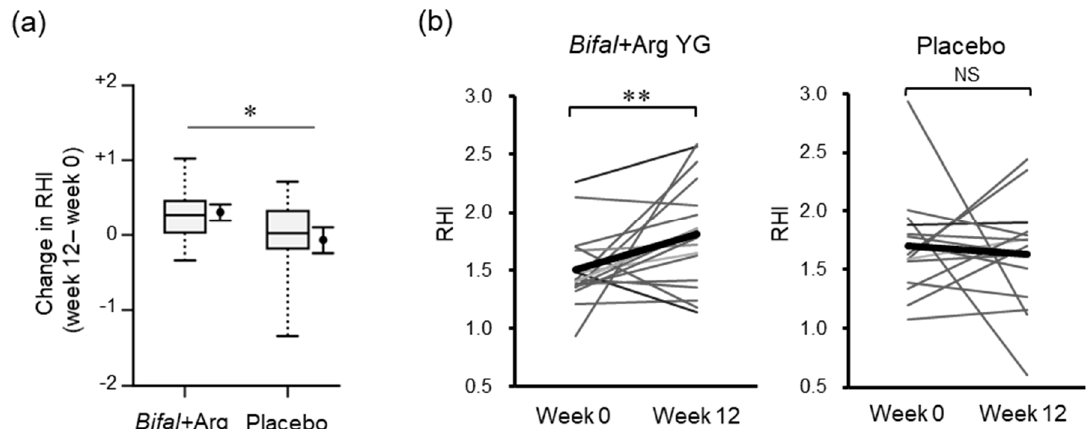
Figure 2. Effect of the consumption of yogurt containing B. animalis subsp. lactis and Arg (Bifal + Arg YG) on the reactive hyperemia index (RHI). Boxplots represent the 5th percentile, 95th percentile, interquartile range (25–75%), and median. The black circle and error bars on the side of the boxplots represent the average value and SEM, respectively. ( a ) Change in RHI during the clinical test period (* p < 0.05, baseline × change interaction p = 0.023 by two-way ANOVA). n = 18 in the Bifal + Arg YG group and n = 15 in the placebo group (one outlier in the placebo group at week 12 was detected; Supplementary Figure S3). ( b ) Change in RHI within each group. The bold line represents the